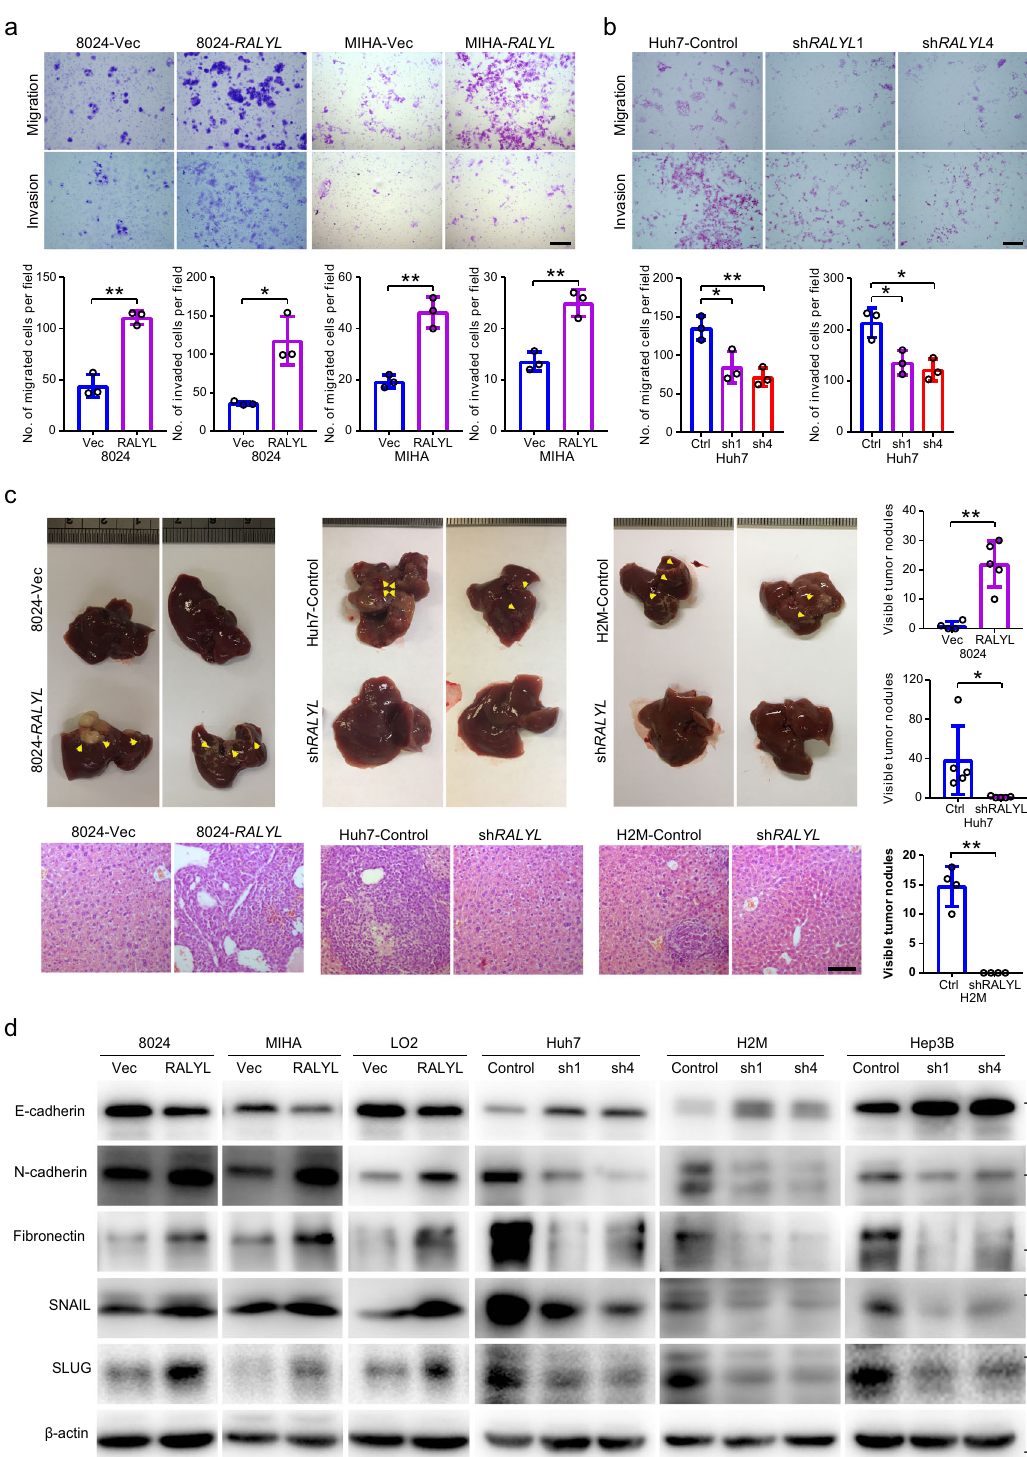
Fig. 3 RALYL promotes HCC migration, invasion and metastatic ability. Cell motilities of 8024-Vec/ RALYL , MIHA-Vec/ RALYL ( a ) and Huh7-Control/ sh RALYLs ( b ) were assessed by transwell migration and matrigel invasion assays. The number of migrated or invaded cells is shown in the bar chart. The values represent the mean ± SD of three independent experiments (* P < 0.05, ** P < 0.01, two-sided Student ’ s t -test). Scale bar = 200 μ m. c Representative images of livers derived from nude mice after intrasplenic injection of indicated cells (up) and representative H&E staining of the corresponding liver sections (down). Scale bar = 200 μ m. The number of metastatic nodules on the liver surface (indicated by yellow arrows) is summarized in the bar charts (right) and represent mean ± SD of four mice of PLC-8024-Vec, fi ve mice of PLC-8024-RALYL, fi ve mice of Huh7-Control or shRALYL, and four mice of H2M-Control or shRALYL (* P < 0.05, ** P < 0.01, independent Student ’ s t test). d The protein expression level of E-cadherin, N-cadherin, fi bronectin, SNAIL, and SLUG of cells transfected with Vec and RALYL , or Control and sh RALYL